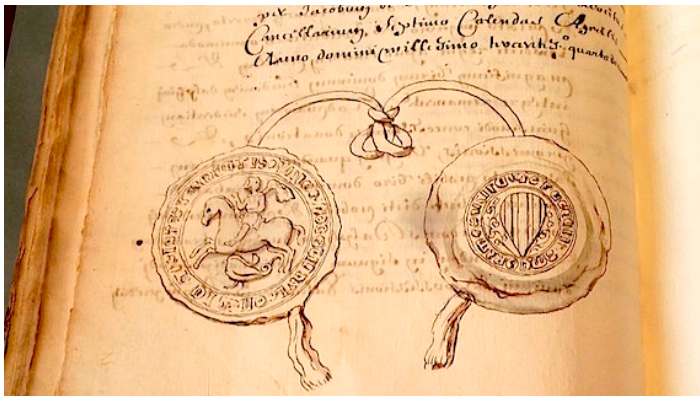
Figure 28. Double seal of the Grand Catalan Company, 1314. Paris, BN lat. 5456, fol. 29v. © Used with permission of Bibliothèque Nationale, Paris.